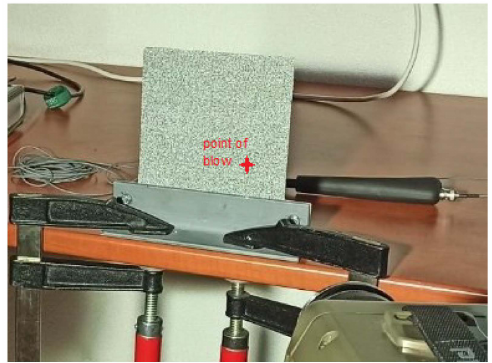
Figure 5. Laying of the analyzed steel plate and the excitation